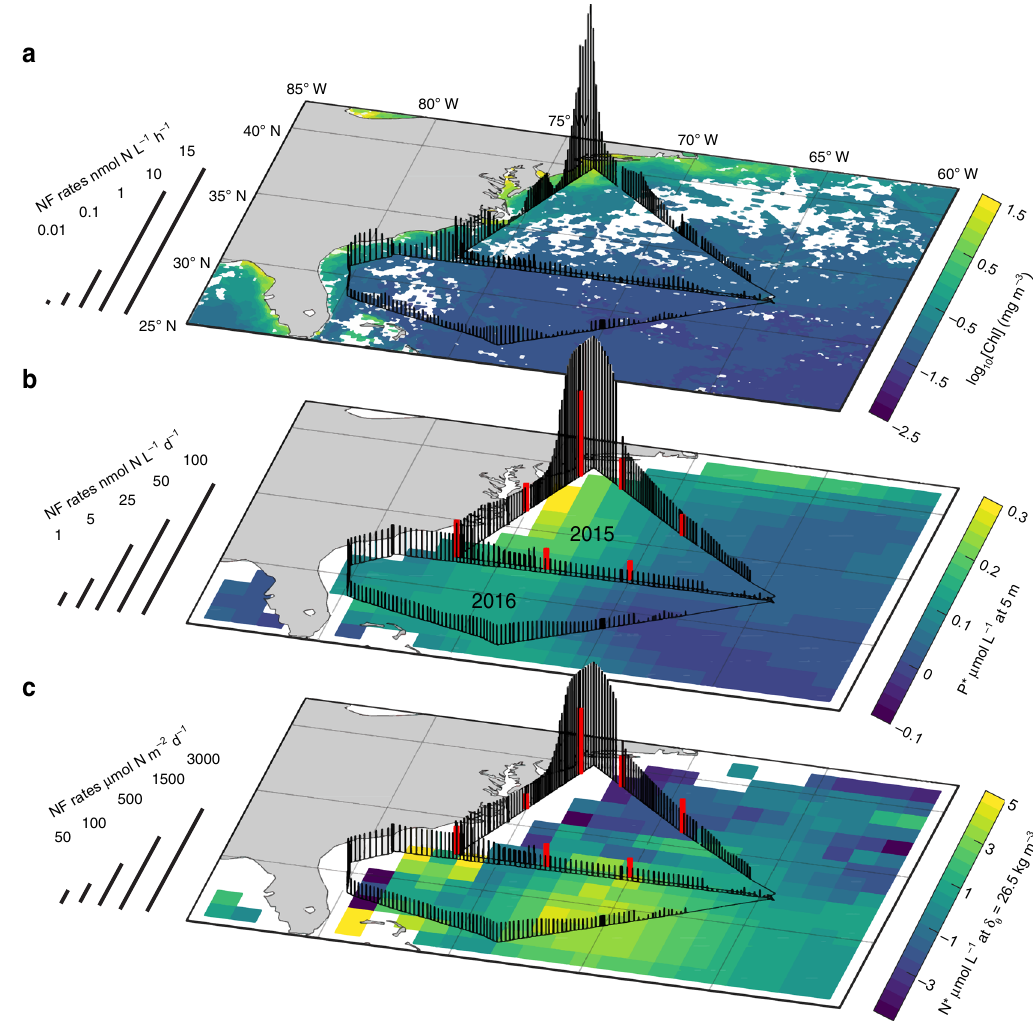
Fig. 1 N 2 fi xation rates (NF) measured and calculated in August 2015 and 2016 over the western North Atlantic Ocean. a In situ hourly surface volumetric N 2 fi xation rates determined by the continuous underway incubation method, overlaid on chlorophyll- a concentrations measured by the MODIS satellite during the respective cruise periods (Aug 3 – 12 in both 2015 and 2016). Note that chlorophyll- a concentrations are shown on a logarithmic scale. (cid:4) (cid:5) (cid:4) (cid:3) ½ NO (cid:3) (cid:4) = 16 . b Calculated daily surface volumetric N 2 fi xation rates overlaid on the August climatology of surface excess phosphate P* P (cid:1) ¼ ½ PO 3 (cid:3) 4 3 Nutrient data were obtained from the World Ocean Atlas 2013 version 2. Red vertical bars represent N 2 fi xation rates determined by the discrete dissolved fi xation rates overlaid on the August climatology of subsurface excess 15 N 2 incubation method during the 2015 cruise. c Estimated depth-integrated N 2 nitrogen N* N (cid:1) ¼ NO (cid:3) 3